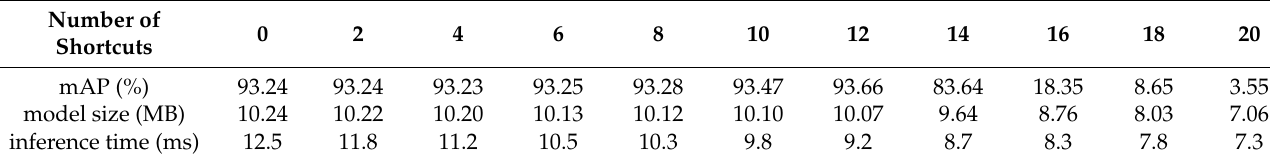
Table 4. Evaluation results of the layer pruning model.